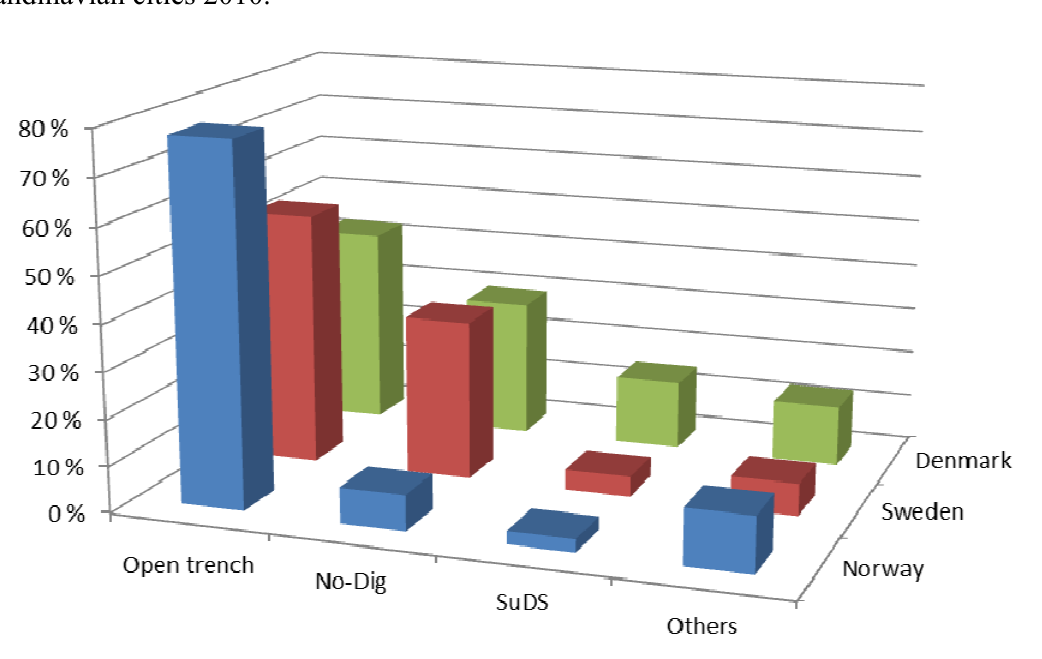
Figure 4. Methods used to improve existing drainage and sewerage systems in the largest Scandinavian cities